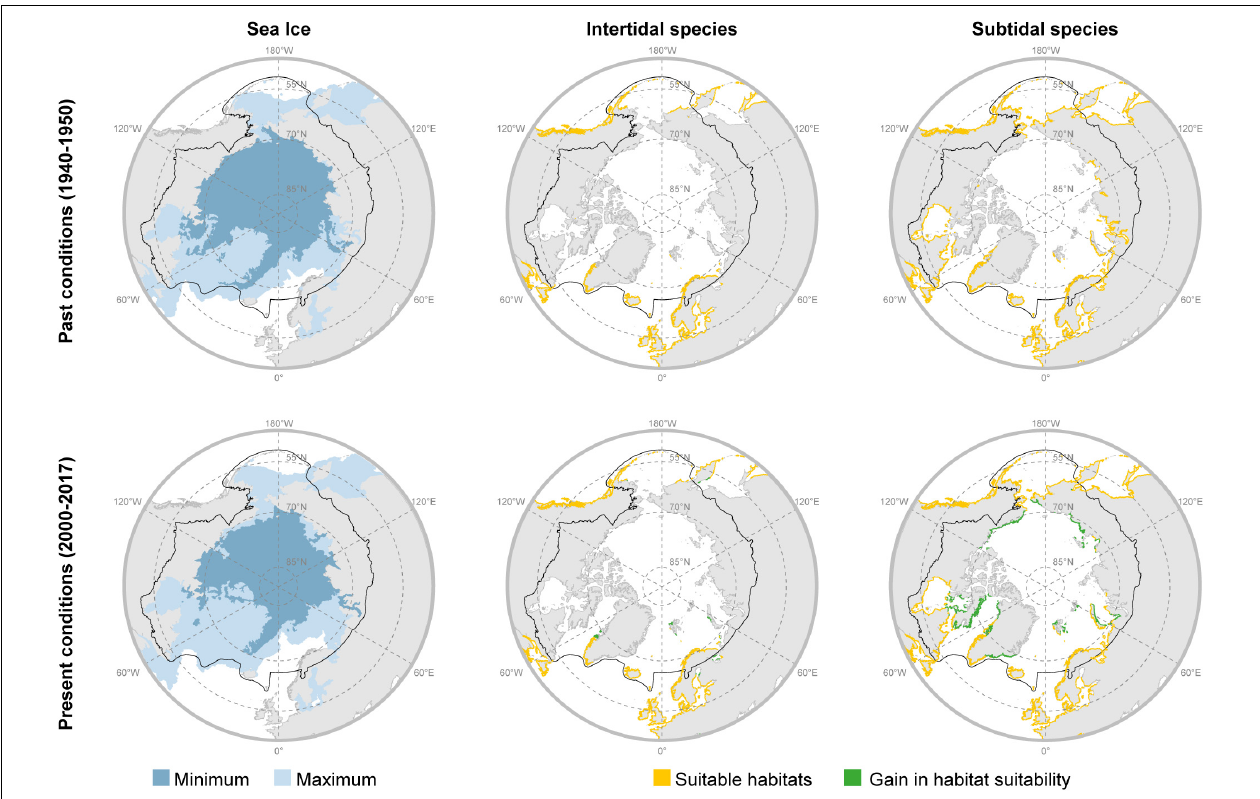
FIGURE 6 | Sea ice conditions and suitable habitat areas for intertidal and subtidal macroalgae predicted for the past (period 1940–1950) and the present (period 2000–2017) in terms of temperature, ice conditions nutrients and salinity, not substrate conditions. Black line depicts the geographic boundaries defined by the Arctic